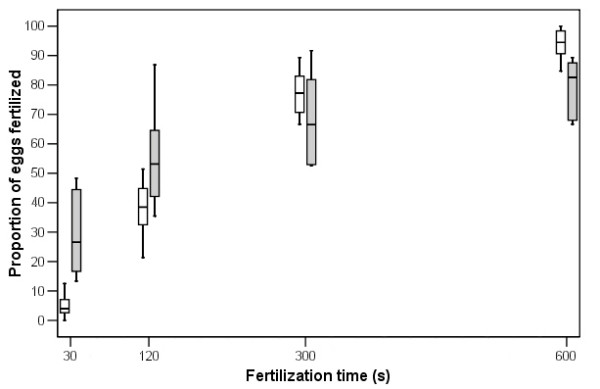
Percentage of fertilized eggs (median, quartiles, range) for the four different fertilization durations. Fertilization was stopped using sparkling mineral water in the main experiment (white bars, N = 9 females), and by washing away the mucus that surrounds the eggs in the control experiment (grey bars, N = 6 females).